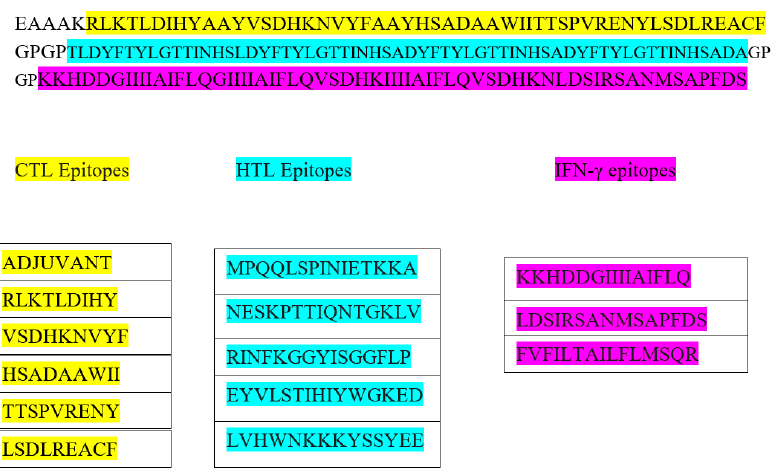
Figure 2. The schematic presentation of constructed vaccine with CTL- in yellow, HTL-in green, and IFN-inducing epitopes in purple, and adjuvant and linker are shown in white color.